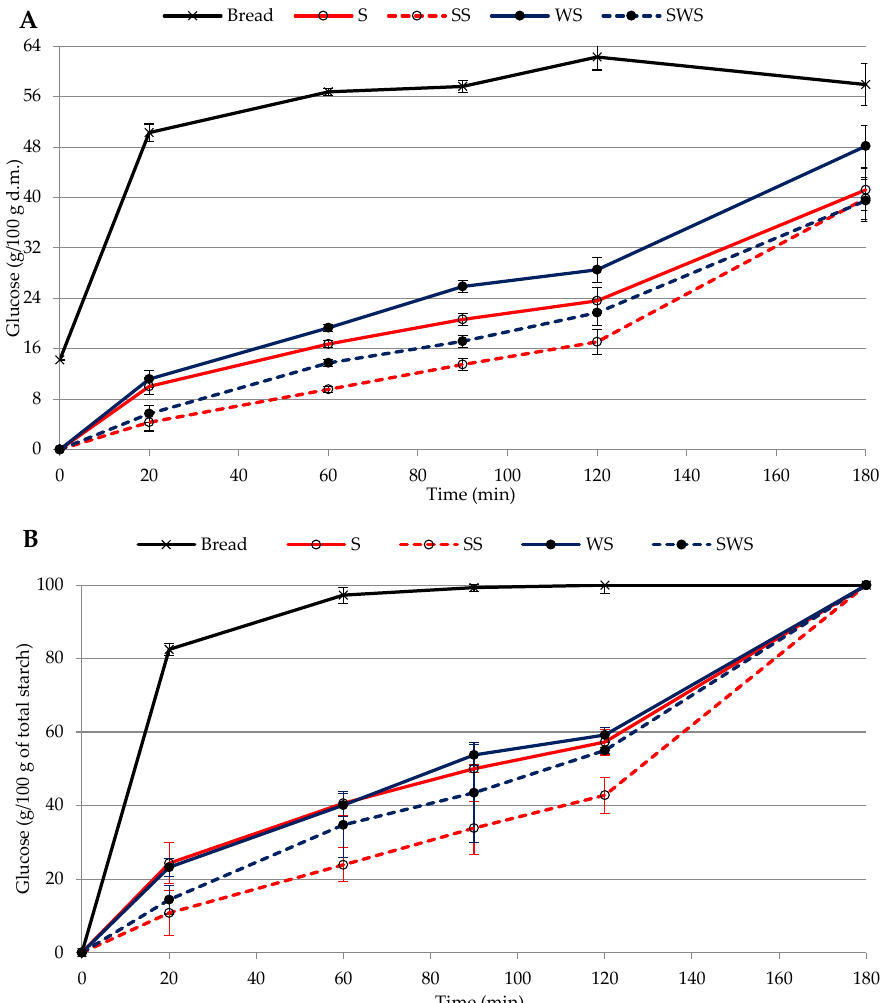
Figure 1. Glucose values from in vitro starch digestion of pasta samples. ( A ) Glucose with respect to dry pasta or bread (g/100 g). ( B ) Glucose with respect to total starch (g/100 g). S, pasta with semolina. SS, pasta with semolina-based sourdough. WS, pasta with wholemeal semolina. SWS, pasta with wholemeal semolina-based sourdough. Bars indicate LSD intervals at 95% confidence level.